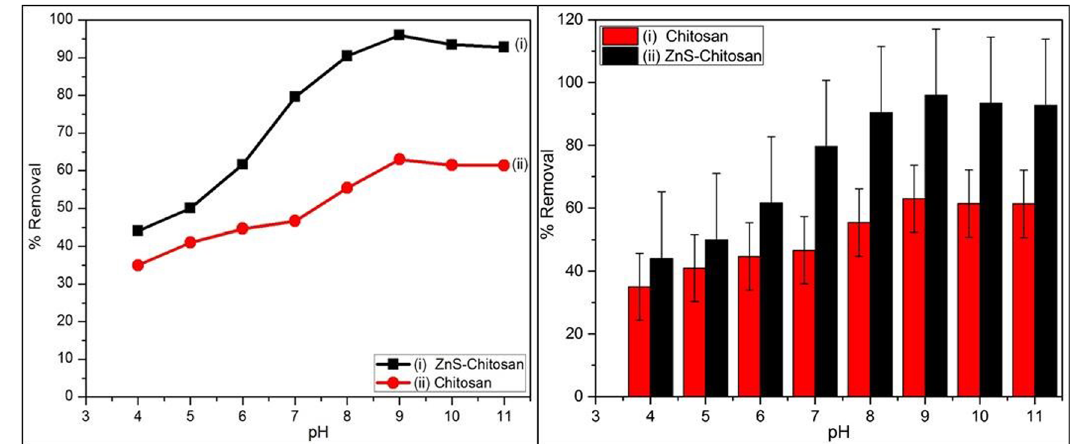
Figure 4: E ff ect of pH on adsorption of Cr ( VI ) ion using chitosan ( i ) and ZnS – chitosan nanocomposites ( ii ) as absorbents.